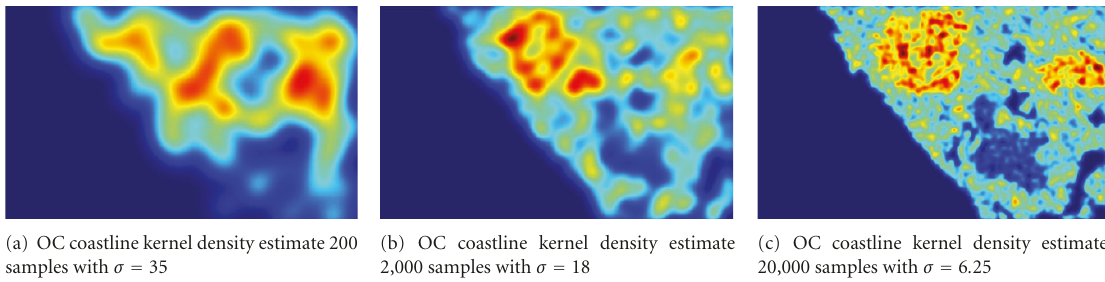
Figure 7: These images are the Gaussian Kernel Density estimates for 200, 2,000, and 20,000 sampled events of the Orange County Coastline example. The color scale for these images is located in Figure